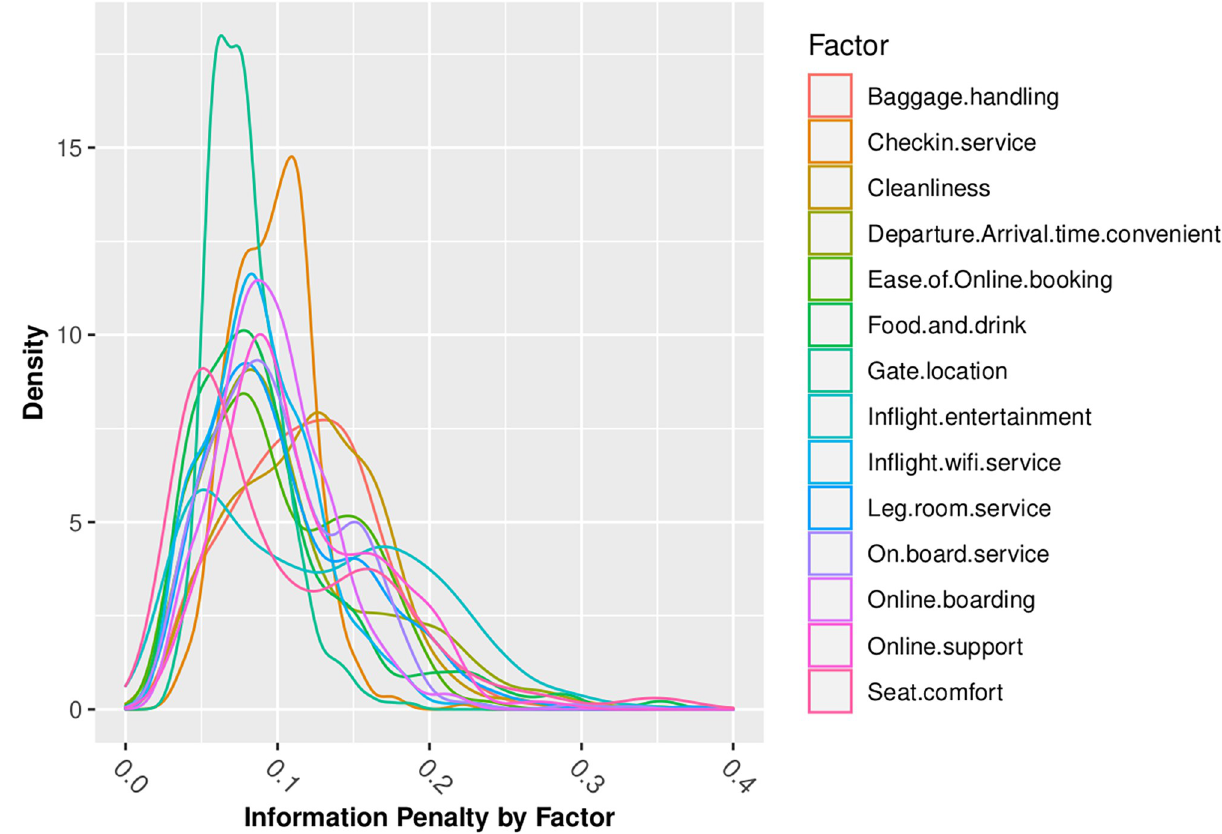
Fig 7. Information penalty (Jeffreys Divergence) assuming poisson